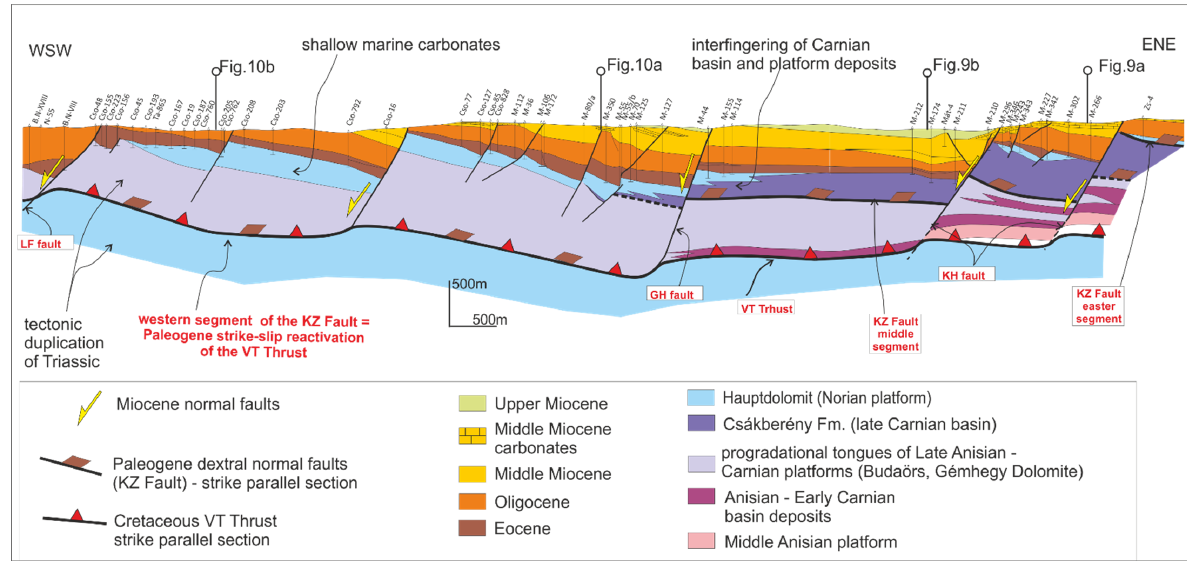
Figure 11. ENE-WSW striking cross-section across the Zsámbék–Mány Basin; for the location of the section, see Figure 4. Note the along-strike variation of the connection between KZ Fault and VT Thrust. In the West, there is only one fault plane, showing the Eocene reactivation of the Cretaceous thrust, while there are two separate fault planes in the East. This change in reactivation style shows a positive correlation with the lateral change in Triassic rheology: massive platform carbonates on the west versus less competent basin intercalations on the east. The strike of major Miocene normal faults (LF, GH, KH Faults) is perpendicular to the section. The abbreviations “Fig.” refer to figures of this